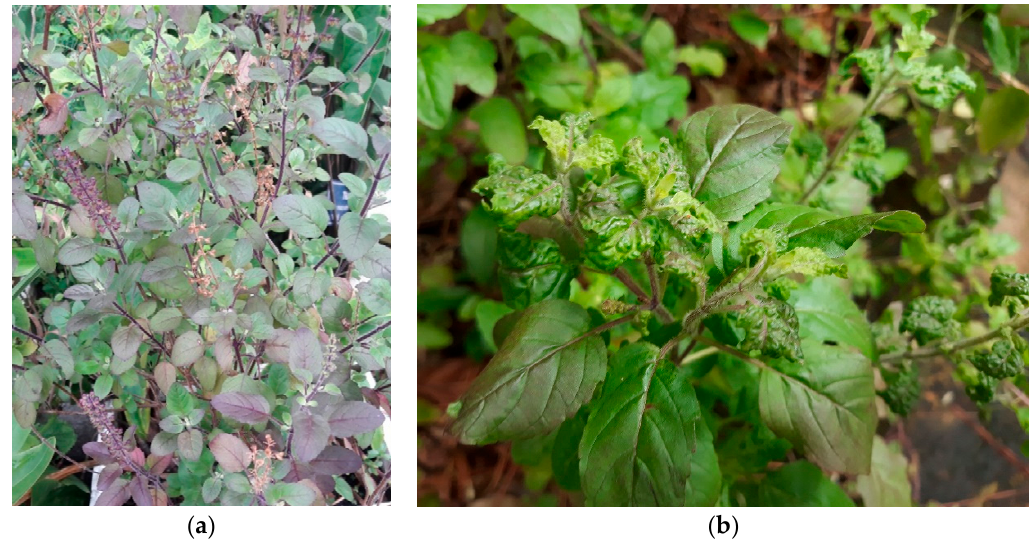
Figure 13. Ocimum sanctum L.: ( a ) whole plant and ( b ) leaves.